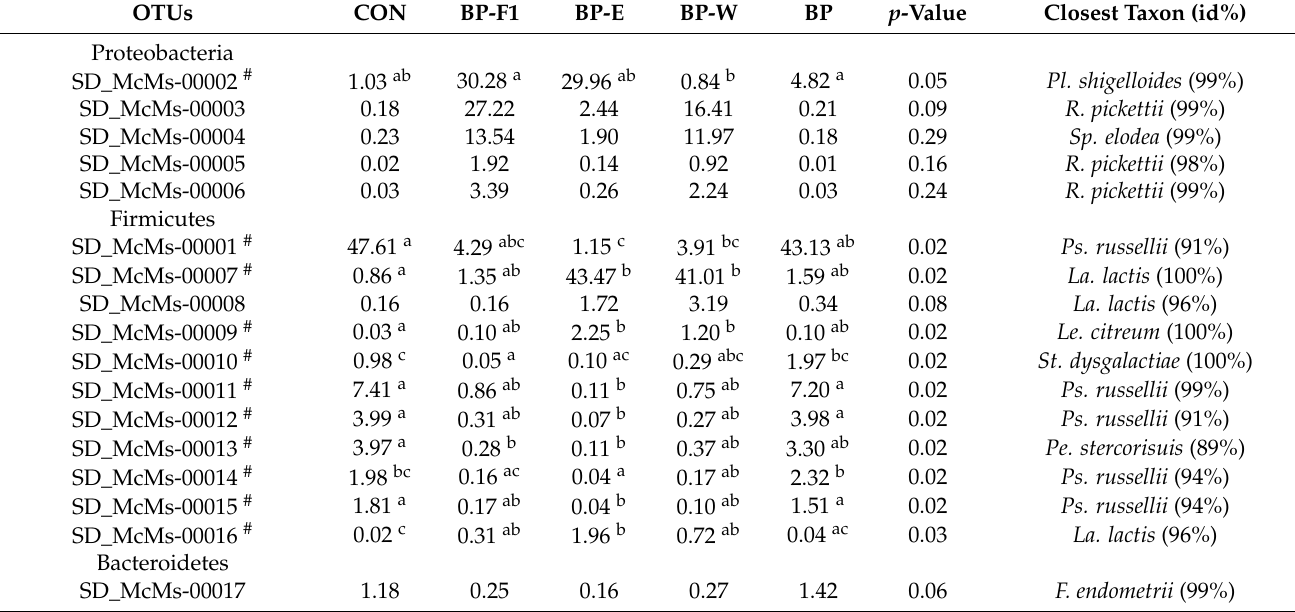
Table 6. Mean relative abundance of the main bacterial OTUs identified in hybrid striped bass. Abundance is presented as a percentage (%) of the total number of analyzed reads per sample.